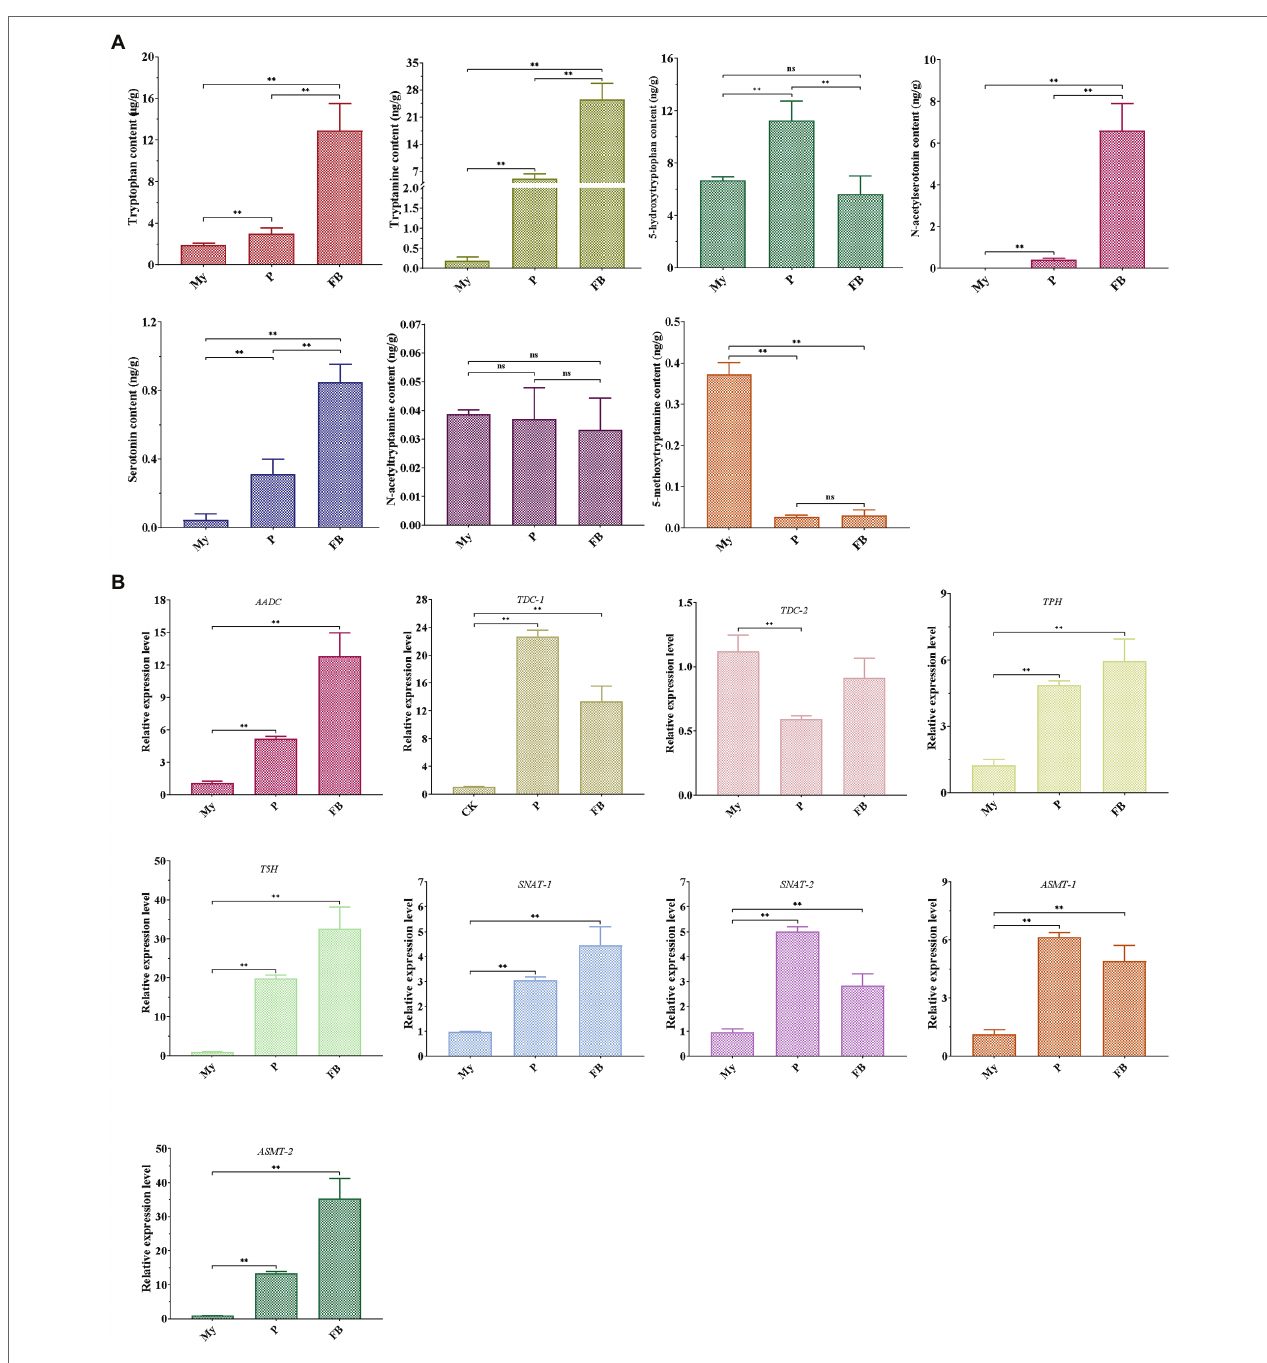
FIGURE 3 | Detection of melatonin-biosynthesis intermediates (A) and the expression pattern of genes related to melatonin synthesis (B) at different development stages of T. guangdongense . My, mycelial stage; P, primordial stage; FB, fruiting body stage; AADC , aromatic-L-amino-acid decarboxylase; TDC , tryptophan decarboxylase; TPH , tryptophan 5-hydroxylase; T5H , tryptamine 5-hydroxylase; SNAT , serotonin N-acetyltransferase; ASMT , acetylserotonin O-methyltransferase; ns, no significant difference. ** , highly significant differences ( p <